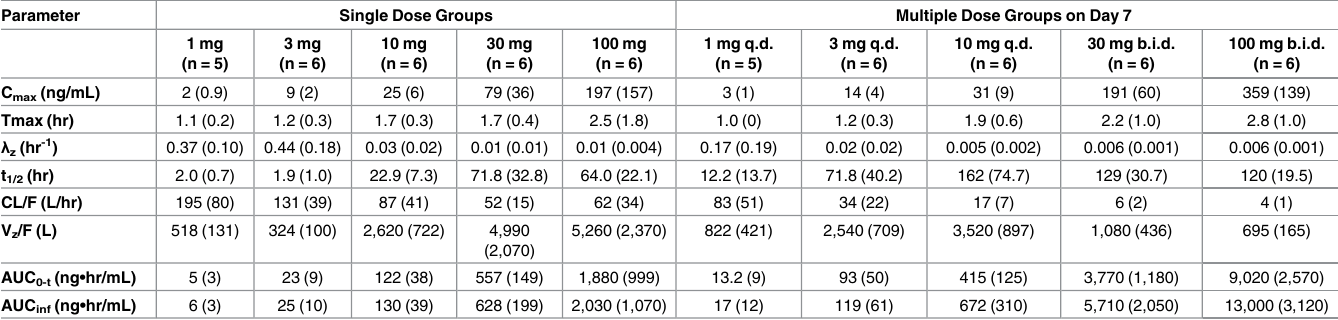
Table 3. Summary of Pharmacokinetic Parameters for CCX168 after Oral Administration to Healthy Human Volunteers.